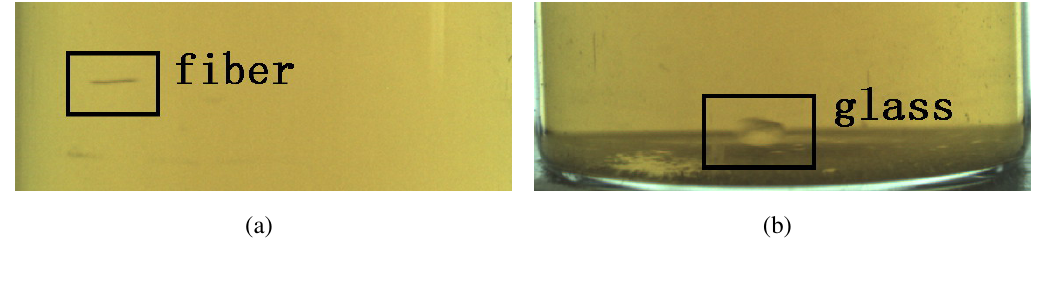
Figure 2. Foreign substances. (a) Fiber, (b) Glass.